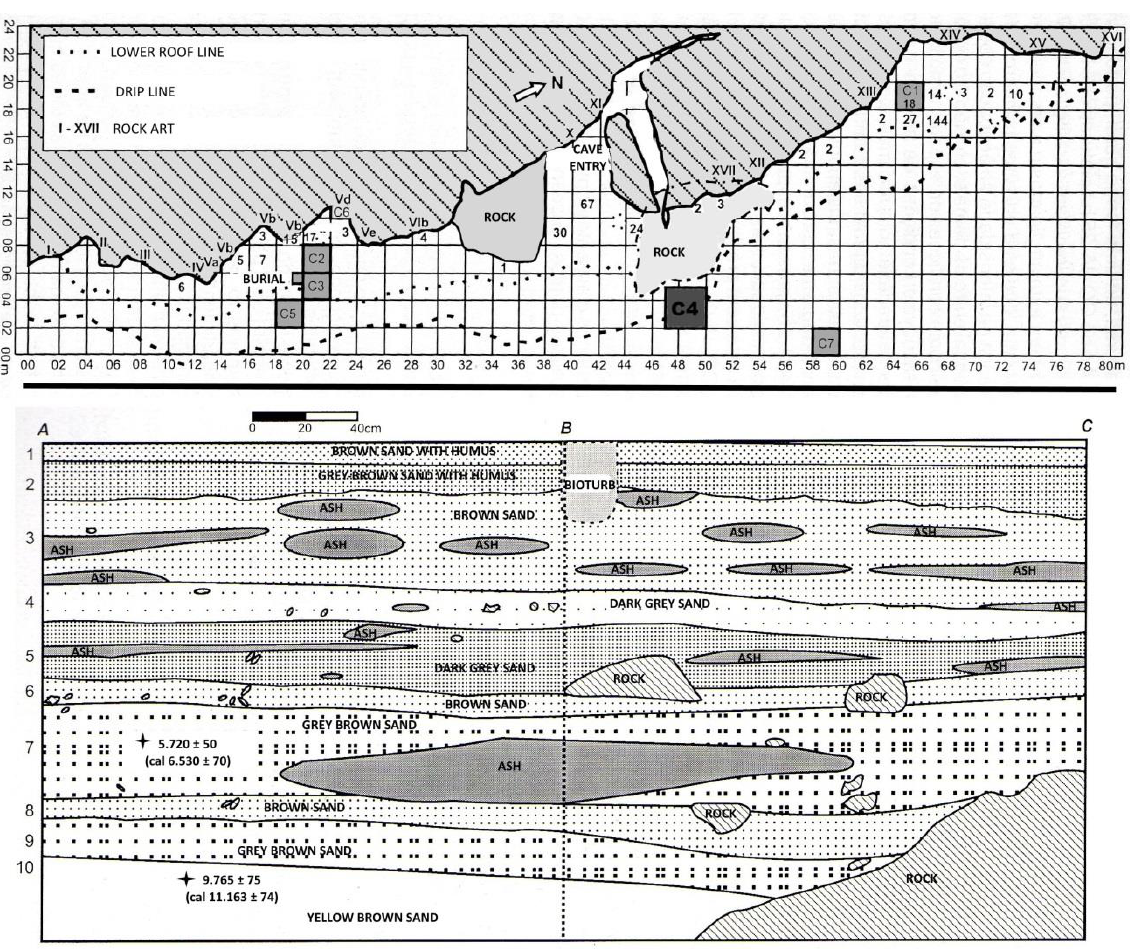
Figure 2. Upper figure: Site map representing the excavation units. Lower figure: Stratigraphy of C4 unit. Adapted from Schmitz